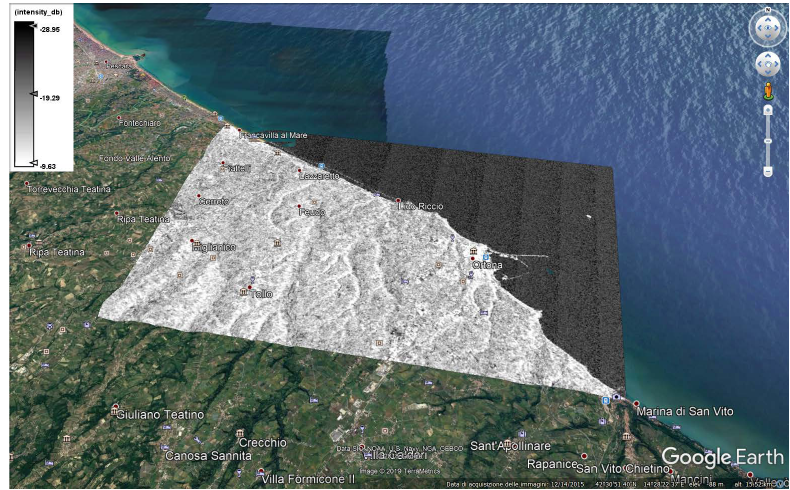
Figure 3. Pre-processed and georeferenced Sentinel-1 image. Date: December 31, 2016. Units: decibels. Polarization: VH polarization. De-speckle filter: